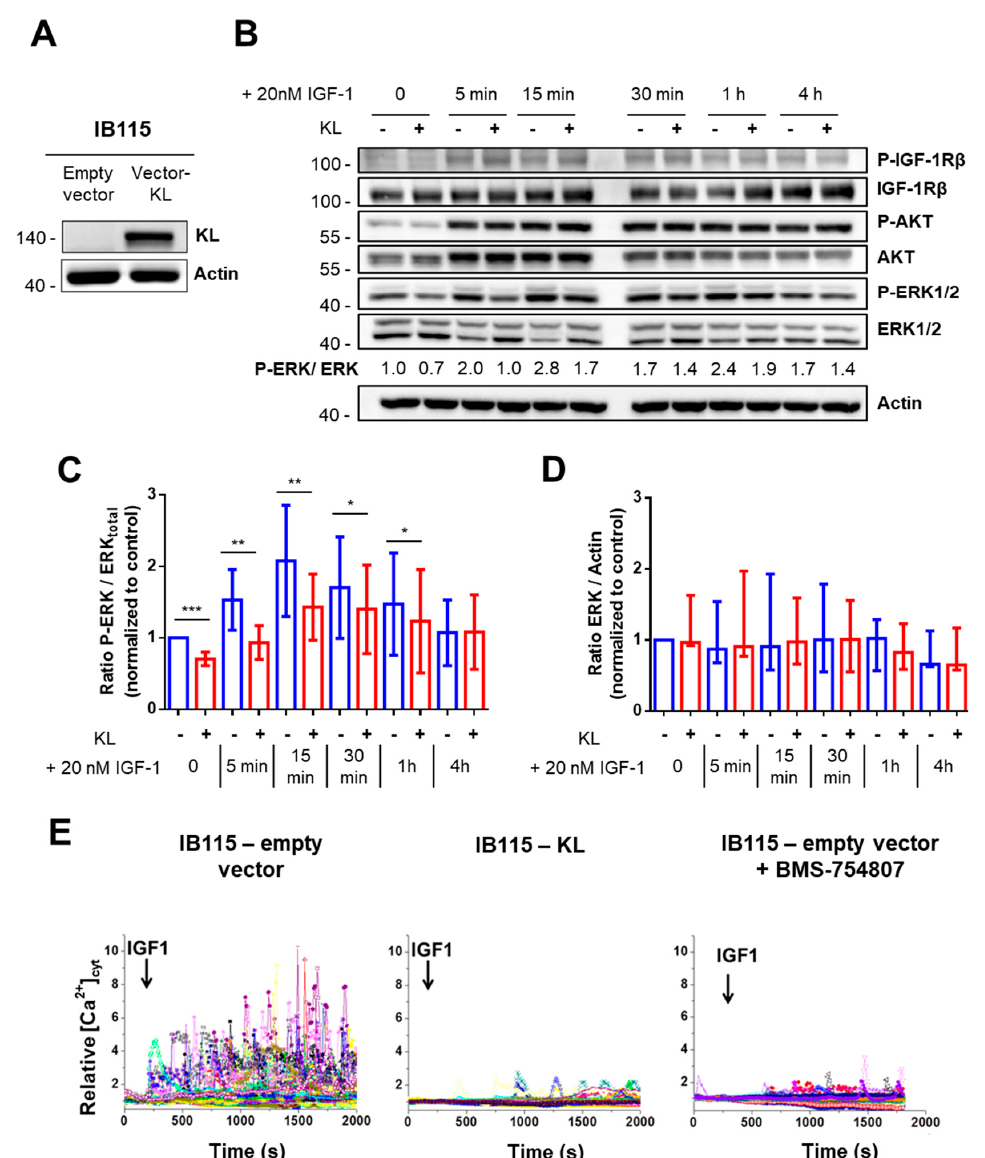
Figure 2. In the DDLPS cell line, Klotho reduces IGF-1R-dependent signaling ( A ) Validation of KL -overexpression in the IB115 cell line by western blotting after lentiviral transduction. The 135 kDa-band was not detected in the control cell line expressing the empty vector. Actin was used as a loading control. ( B ) Western blot analysis of IGF-1R β , AKT, and ERK1/2 phosphorylation statuses during